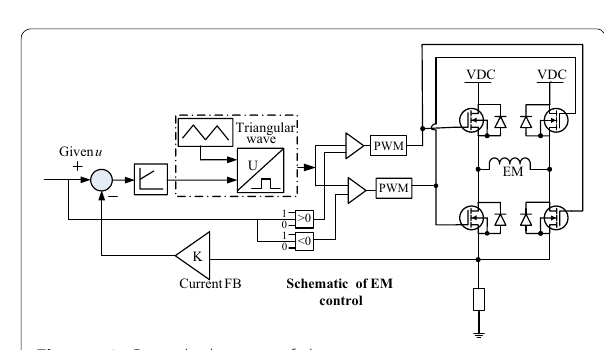
Figure 12 Control schematic of